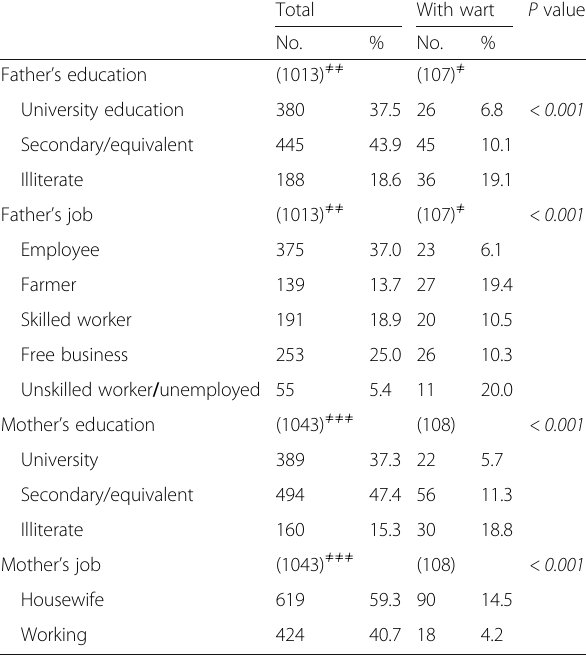
Table 2 Relation between wart infection of primary school students and parent ’ s education and job, academic year 2015